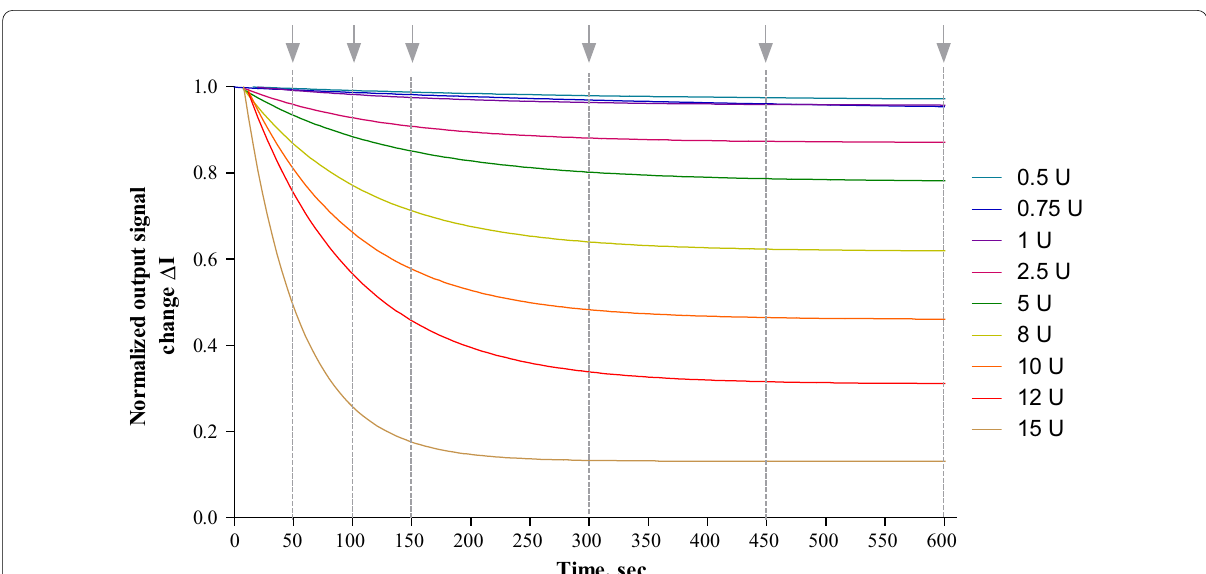
Fig. 3 The normalized biosensor output signal change (ΔI) at different cellulase activity. The cellulose samples were incubated in air-saturated 1% CMC solution in 0.1 M acetate buffer (pH 5.0) at 25 °C; the final concentration of glucose oxidase added was 12 U/ml; measurement time at constant stirring was 600 s